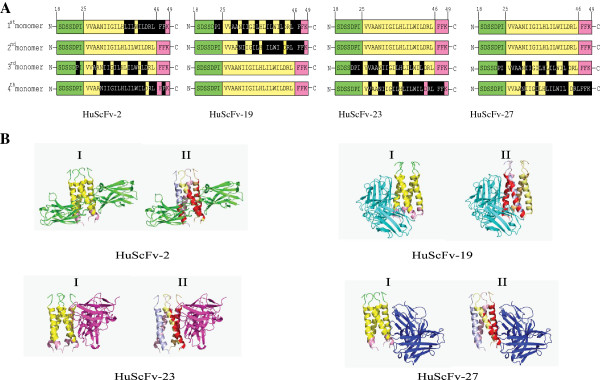
Residues and areas of individual monomers of tetrameric M2 ion channel interacted with the HuScFv. (A) Predicted M2 residues (black shades) in individual monomers of the ion channel which were bound by the HuScFv. (B) Results of molecular docking between the HuScFv with the tetrameric M2 ion channel template which was obtained from PDB entry 2LY0. (I) Interaction of HuScFv-2 (green), -19 (cyan), -23 (violet) and -27 (blue) with tetrameric M2 ion channel template. The so-obtained template contained only six residues of ectodomain (green), complete transmembrane helix (yellow) and 3 residues of amphipathic helix (pink) but lacked completely the C-terminal residues. (II) Regions (red shades) of individual M2 monomers (colored in light blue, light pink, light brown and pale yellow for monomers 1–4, respectively) that interacted with the HuScFv.